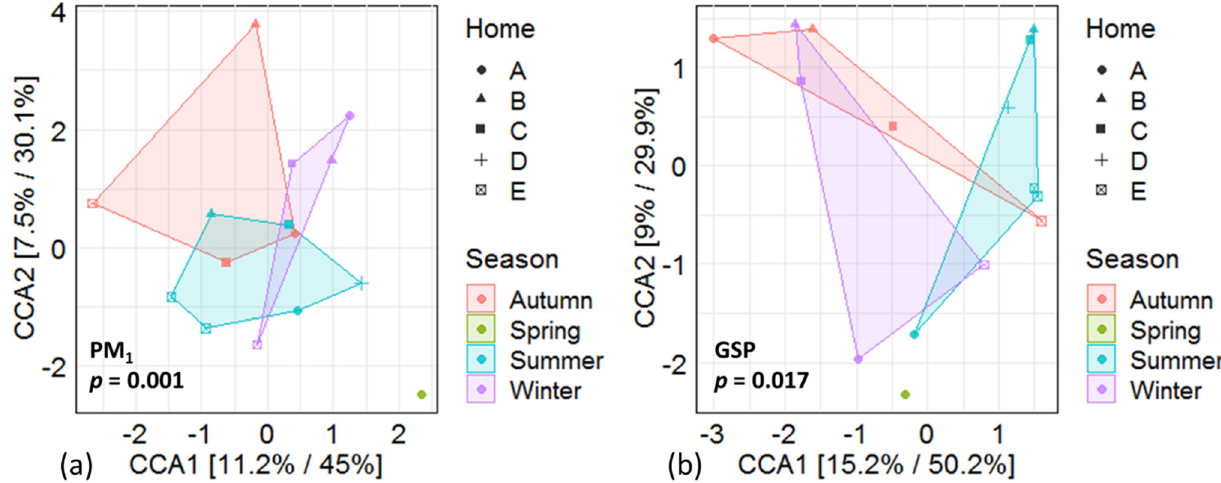
Figure 1. Canonical correspondence analysis (CCA) of the fungal β -diversity of the different fungi in PM 1 ( a ) and GSP ( b ) samples both constrained by season. Table 2. Seasonal differences between the concentrations of DNA copies in PM 1 samples positive for fragments.